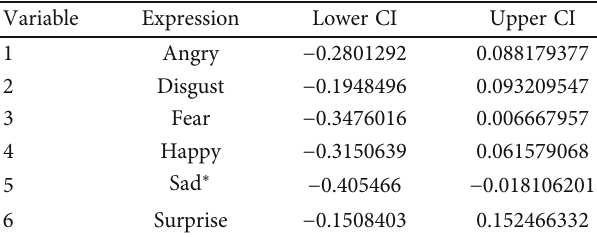
Table 2: 95% Bonferroni simultaneous con fi dence